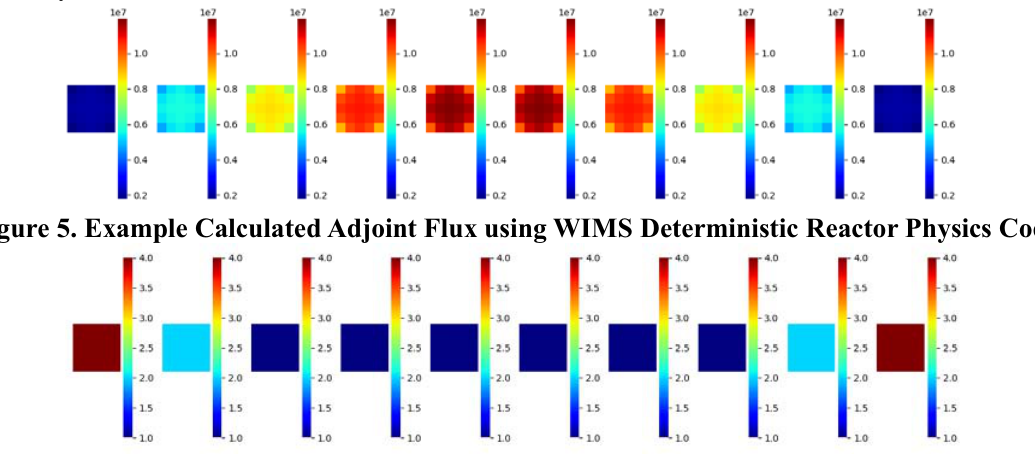
Figure 6. Generated Importance Map (Forced